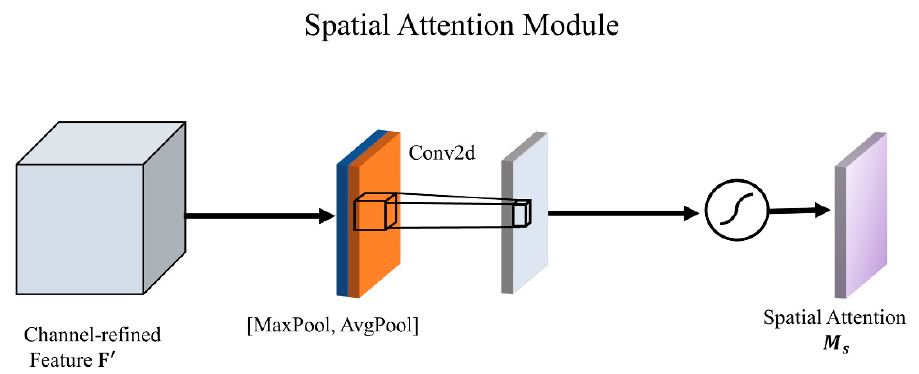
Figure 5. Spatial attention module.